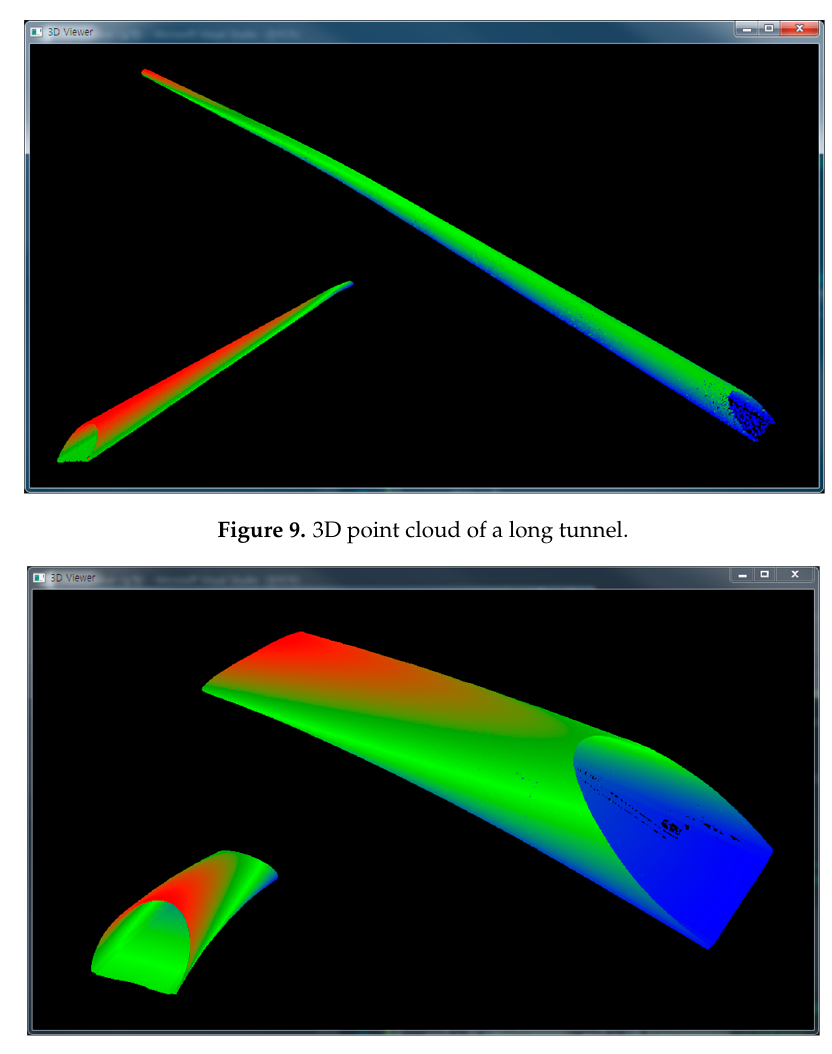
Figure 10. 3D point cloud of a short tunnel.